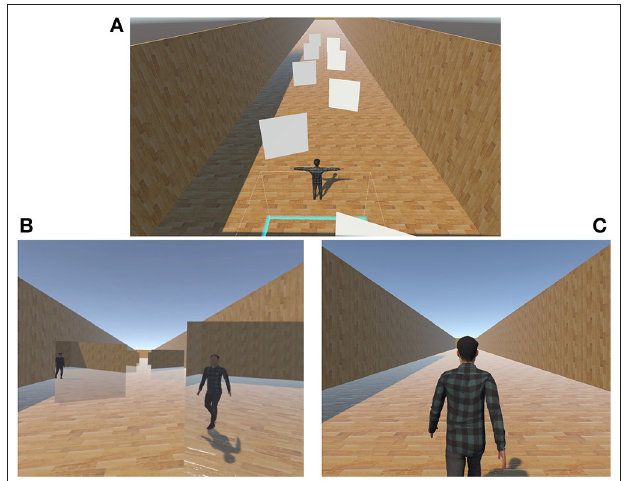
FIGURE 2 | Visual scenes. (A) Top view of virtual environment in experiment 1. In experiment 2, mirrors were excluded. (B) Example scene in experiment 1. (C) Example scene in experiment